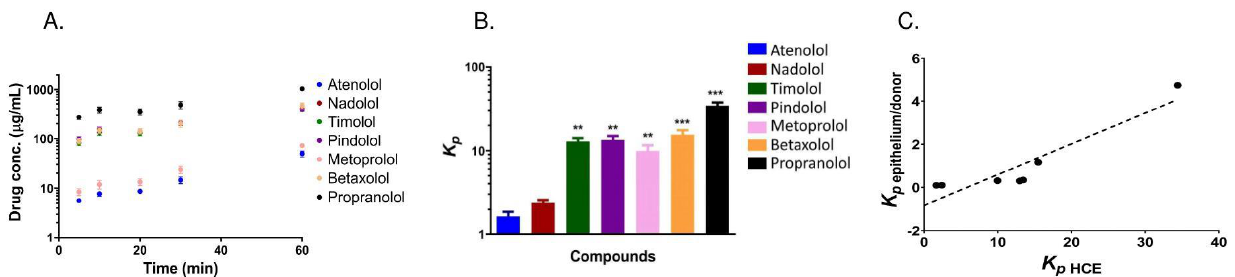
Figure 5. ( A ) The intracellular concentrations of beta-blocking drugs in the HCE cells at different times. The cells were incubated with 30 µg/mL of each drug. ( B ) HCE/donor partition coefficients ( K p ) for beta-blocking drugs after 60 min drug exposure. Statistical analysis was done by ANOVA on ranks with Dunnett’s test: ** p < 0.01 and *** p < 0.001 by comparing the values of other beta-blocking agents to atenolol. The results are expressed as mean ± standard error of the mean (SEM), n = 9. ( C ) Correlation between K p of epithelium/donor and K p of HCE cells/medium (R 2 = 0.925). The K p values represent mean values ( n = 6 and 9 for K p epithelium/donor and K p HCE, respectively.).